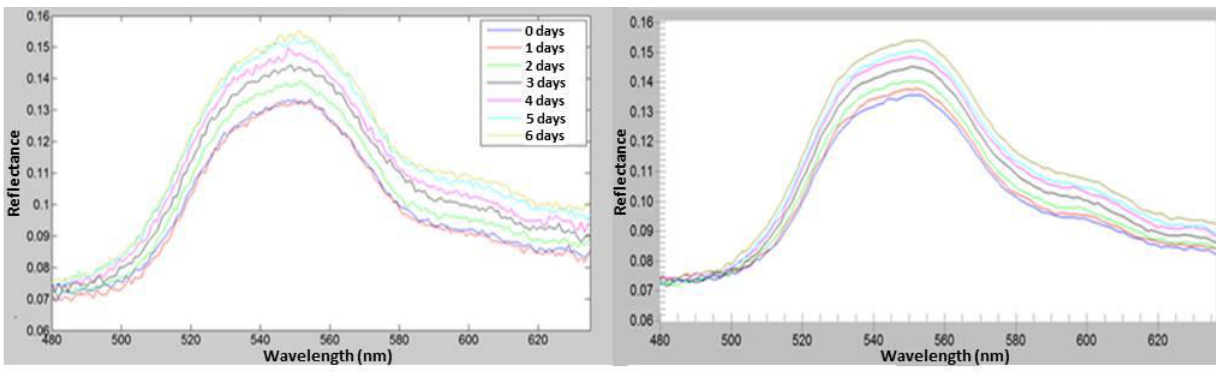
Figure 13. Spectra of an Ivy leaf after it has been removed from the plant. Measurements are taken using our instrument ( left ) and an ASD Fieldspec 3® ( right ) at the same time every day for 6